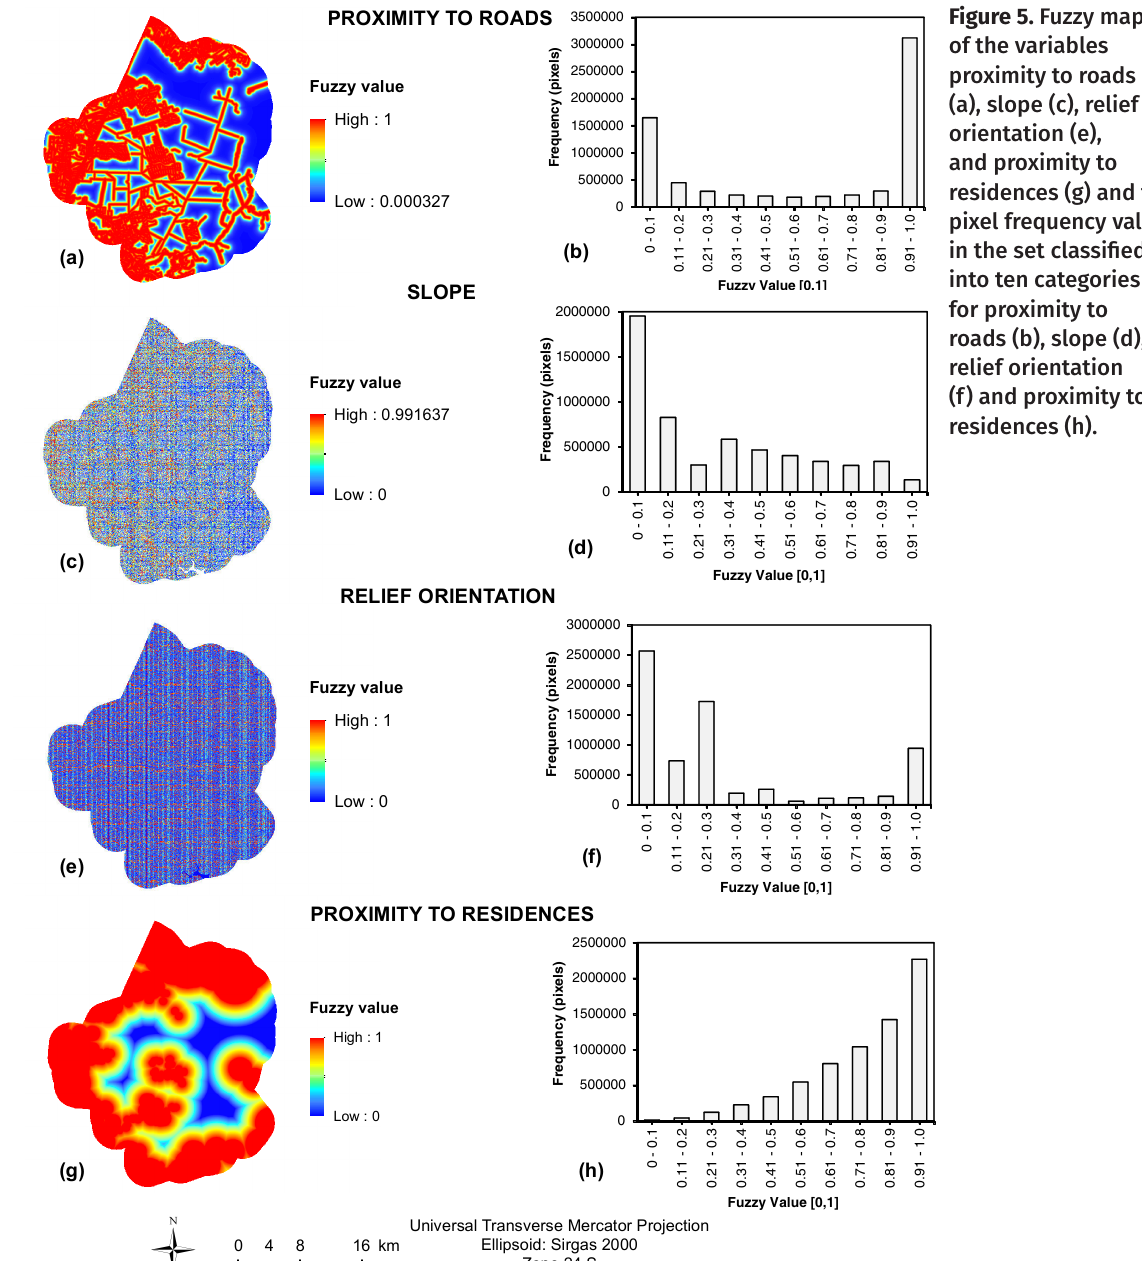
Figure 5. Fuzzy map of the variables proximity to